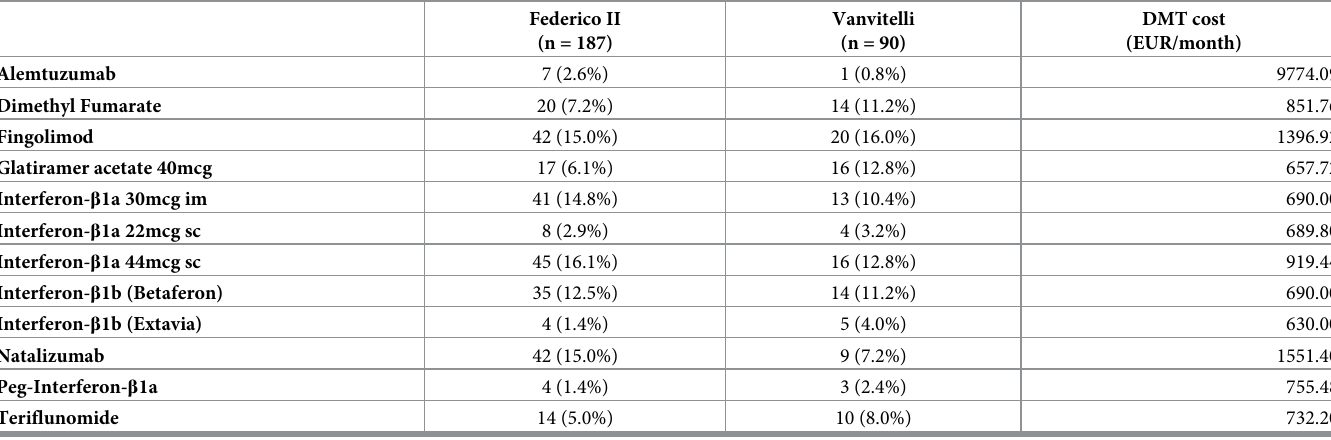
Table 2. DMT utilization at Federico II and Vanvitelli MS